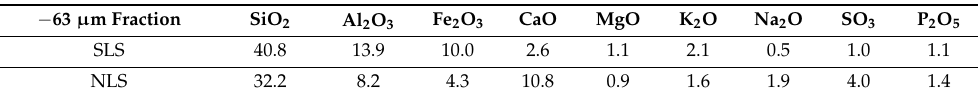
Table 11. Major oxides composition (%) for each − 63 µ m fraction provided to study sediment incorporation into SMCs and lightweight